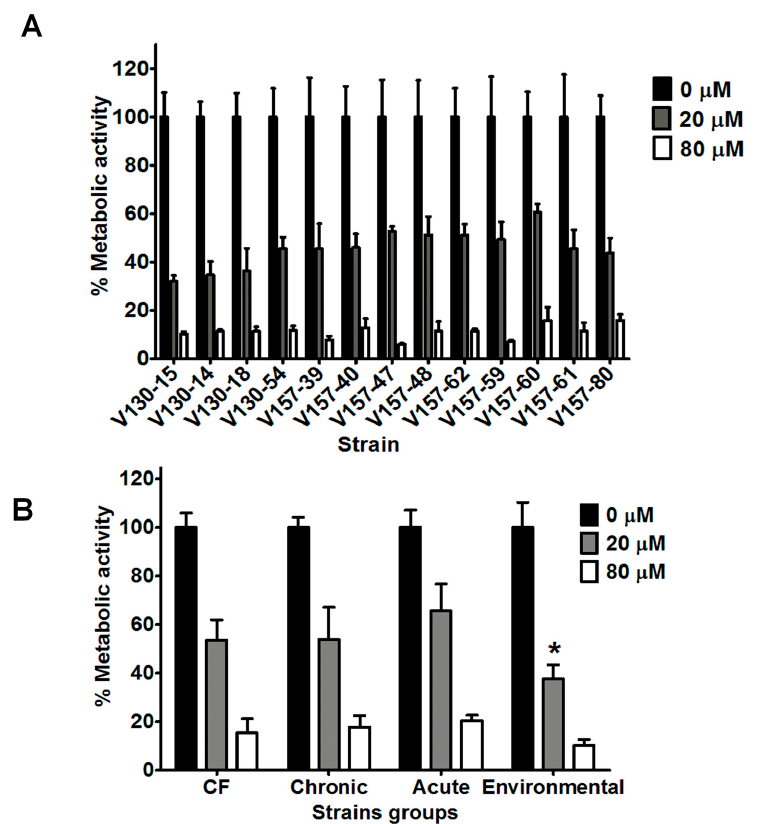
Figure 2. Antifungal activity of lysozyme against a range of A. fumigatus isolates. ( A ) Metabolic activity of the series of clinical isolates after 2 h incubation with lysozyme (20 or 80 µM). ( B ) Metabolic activity of strains of various clinical and environmental origins (data from 5 strains is combined into each group) after 2 h incubation with lysozyme (20 or 80 µM). In each experiment, hyphae were grown overnight in RPMI and the media was refreshed prior to adding the peptide in phosphate buffered saline. Metabolic activity was determined by XTT assay. Data were obtained in two independent experiments, each with triplicate readings; mean values ± SD are shown. * denotes statistical difference when compared to CF, chronic and acute means for incubation with 20 µM lysozyme (two tailed t -test; p < 0.0001).